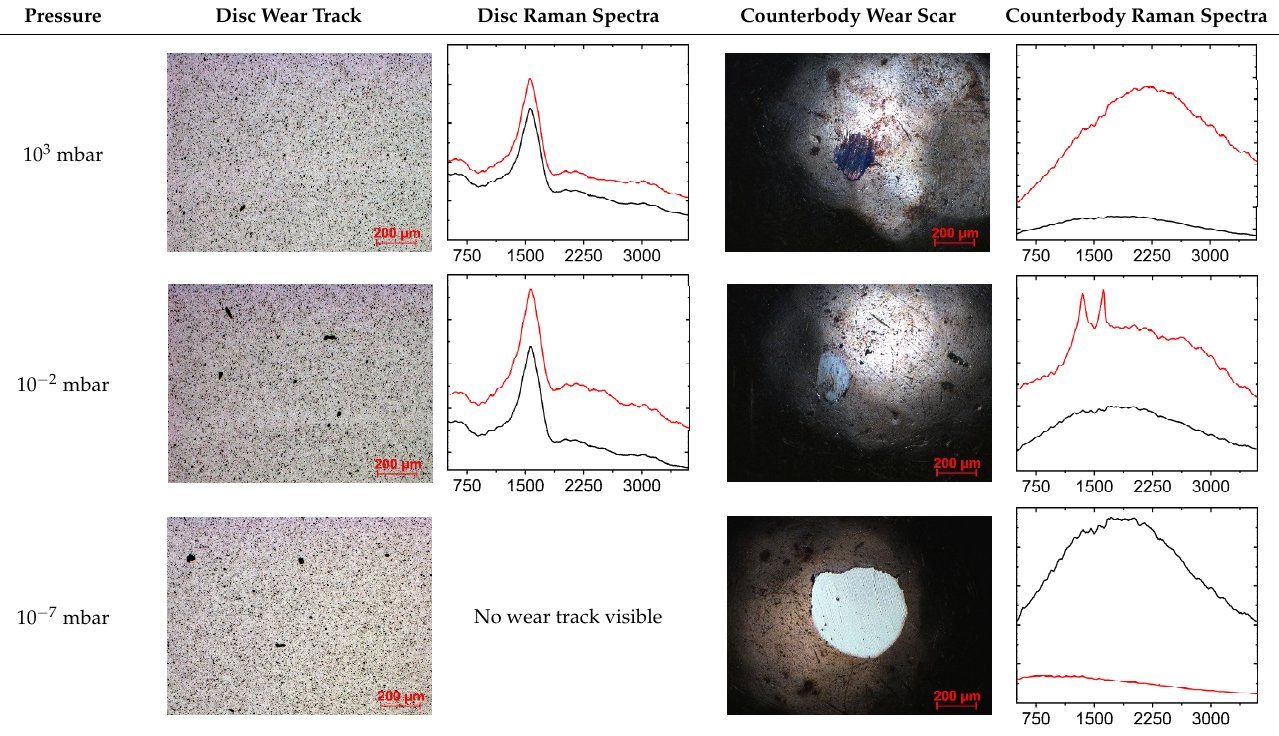
Table 2. Brass/ta-C pairs tested at pressures of 10 3 , 10 − 2 , and 1.1 × 10 − 7 mbar. Microscopic images of disc and counterbody wear tracks are shown with corresponding Raman signal. Red line shows signal in tribological contact area, and black line shows signal from pristine area outside the contact area. Y -axis = intensity (a.u.); X -axis = Raman shift/cm − 1 .